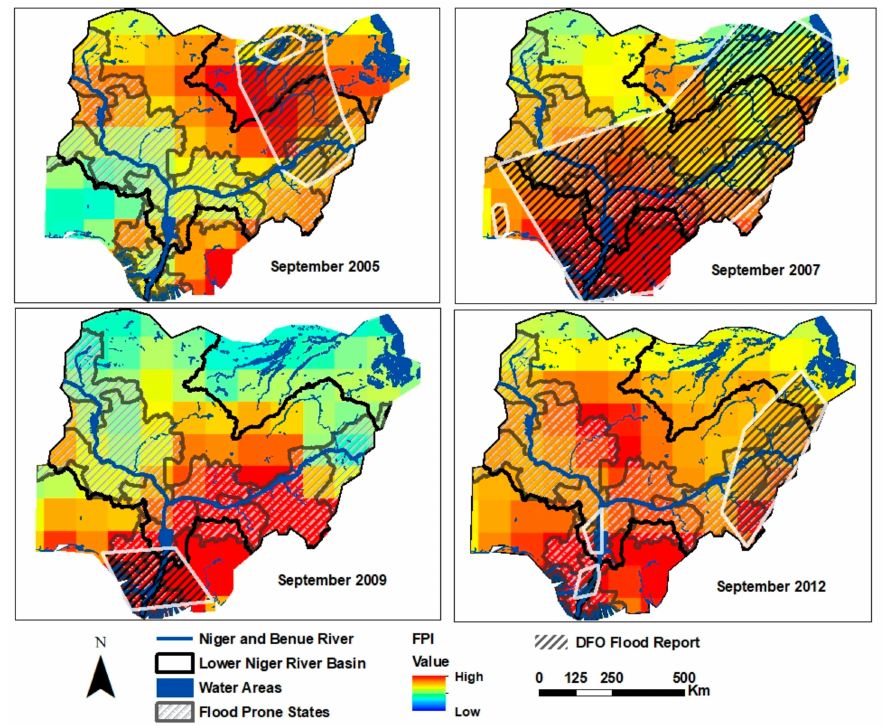
Figure 14. Comparison between GRACE-based FPI predicted floods and DFO reported